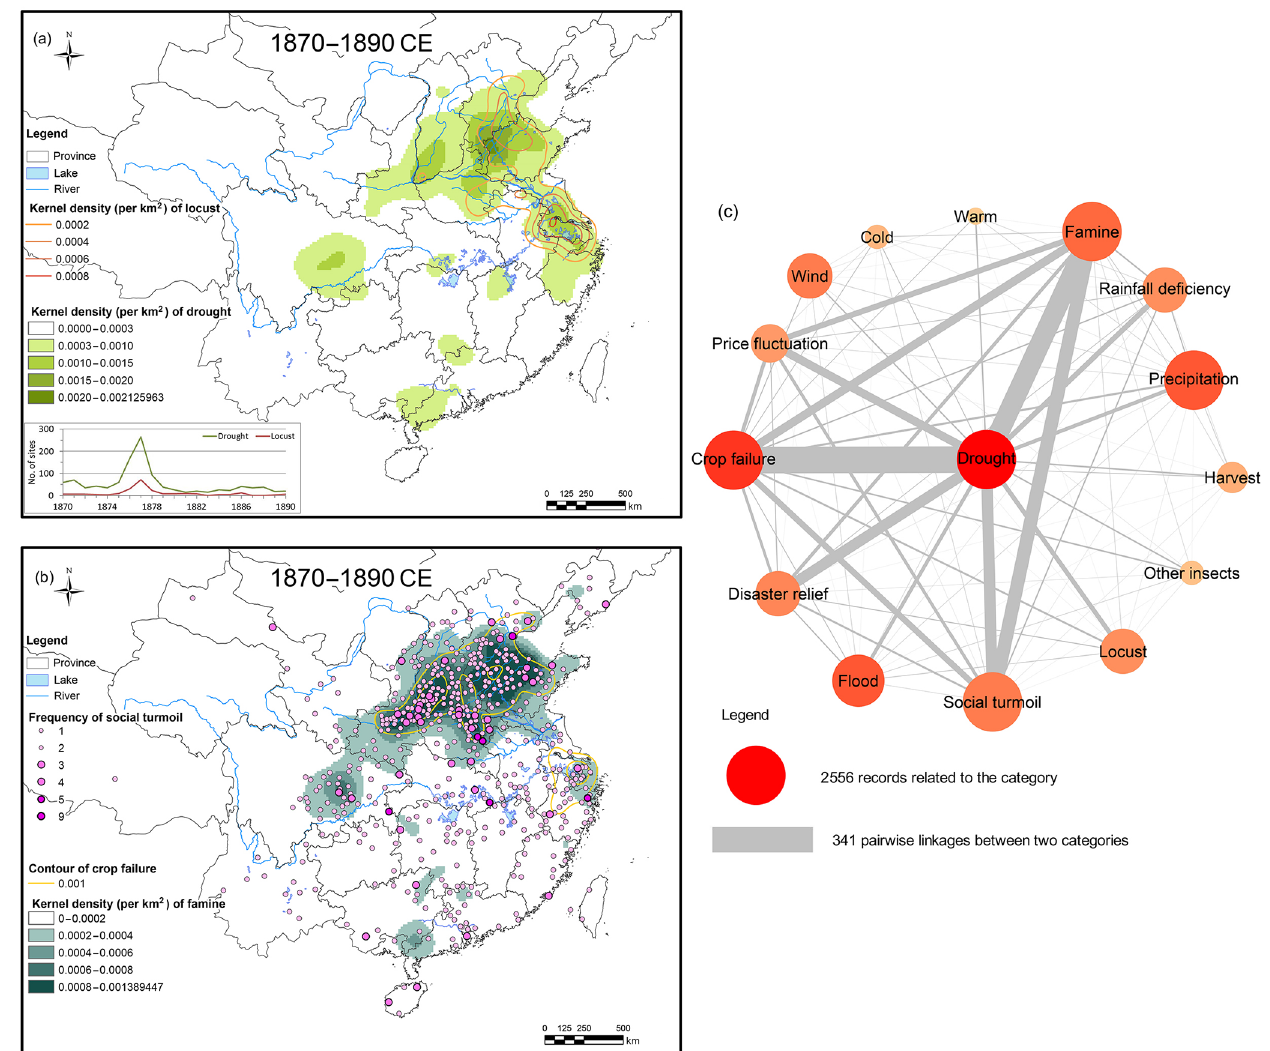
Figure 12. Spatial distribution of the kernel density function of drought and locust outbreaks (a) and social turmoil (b) , and the social network chart (c) in the drought period